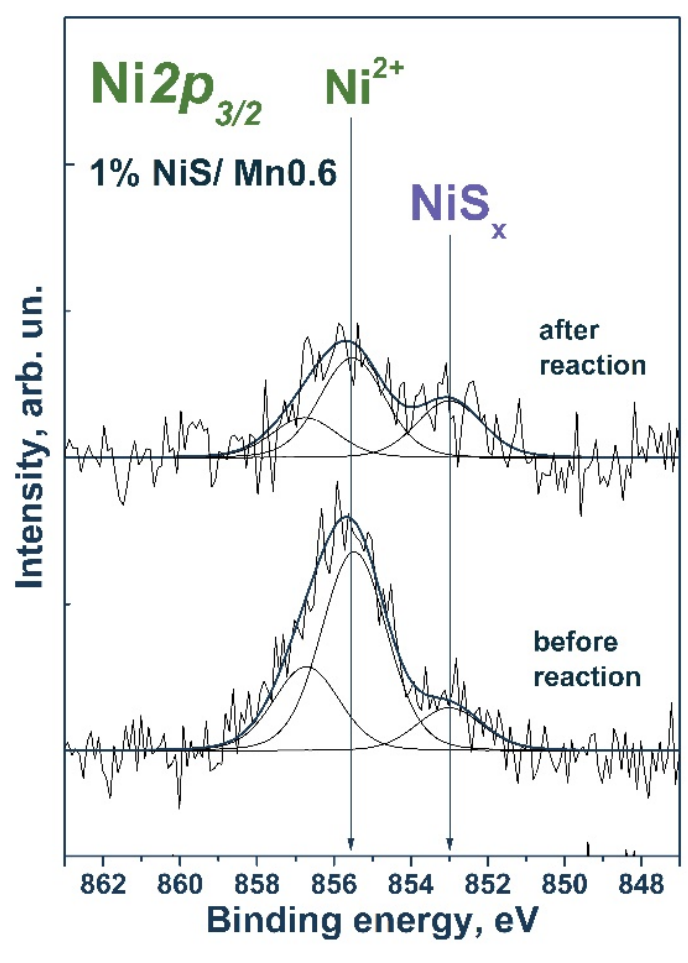
Figure 9. Ni 2p 3/2 spectrum of the studied samples. The spectrum is normalized to the integral total intensity of the corresponding Mn 2p spectra .